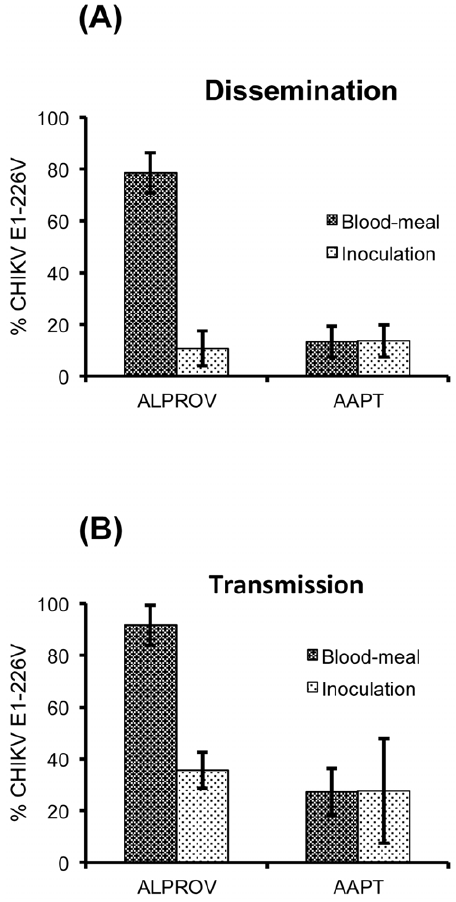
Figure 6. Effects of intrathoracic injection compared to blood- meal ingestion on CHIKV dissemination and transmission in Ae. aegypti (AAPT) and Ae.albopictus (ALPROV). Ae. aegypti and Ae. albopictus were orally infected or inoculated with E1-226A and E1-226V provided at the same titer, 10 6.5 pfu/mL. At day 7 post-infection, dissemination (A) and transmission (B) were examined by estimating the proportion of E1-226V in wings and saliva. Error bars show the confidence intervals (95%).